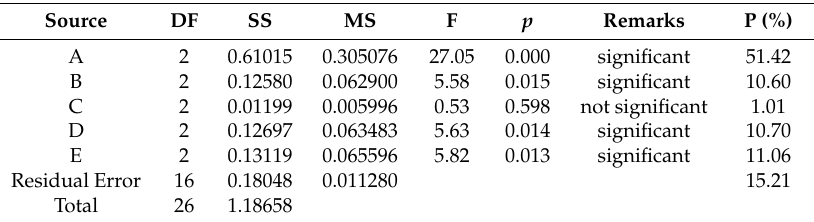
Table 8. ANOVA for the S/N ratio (WI).